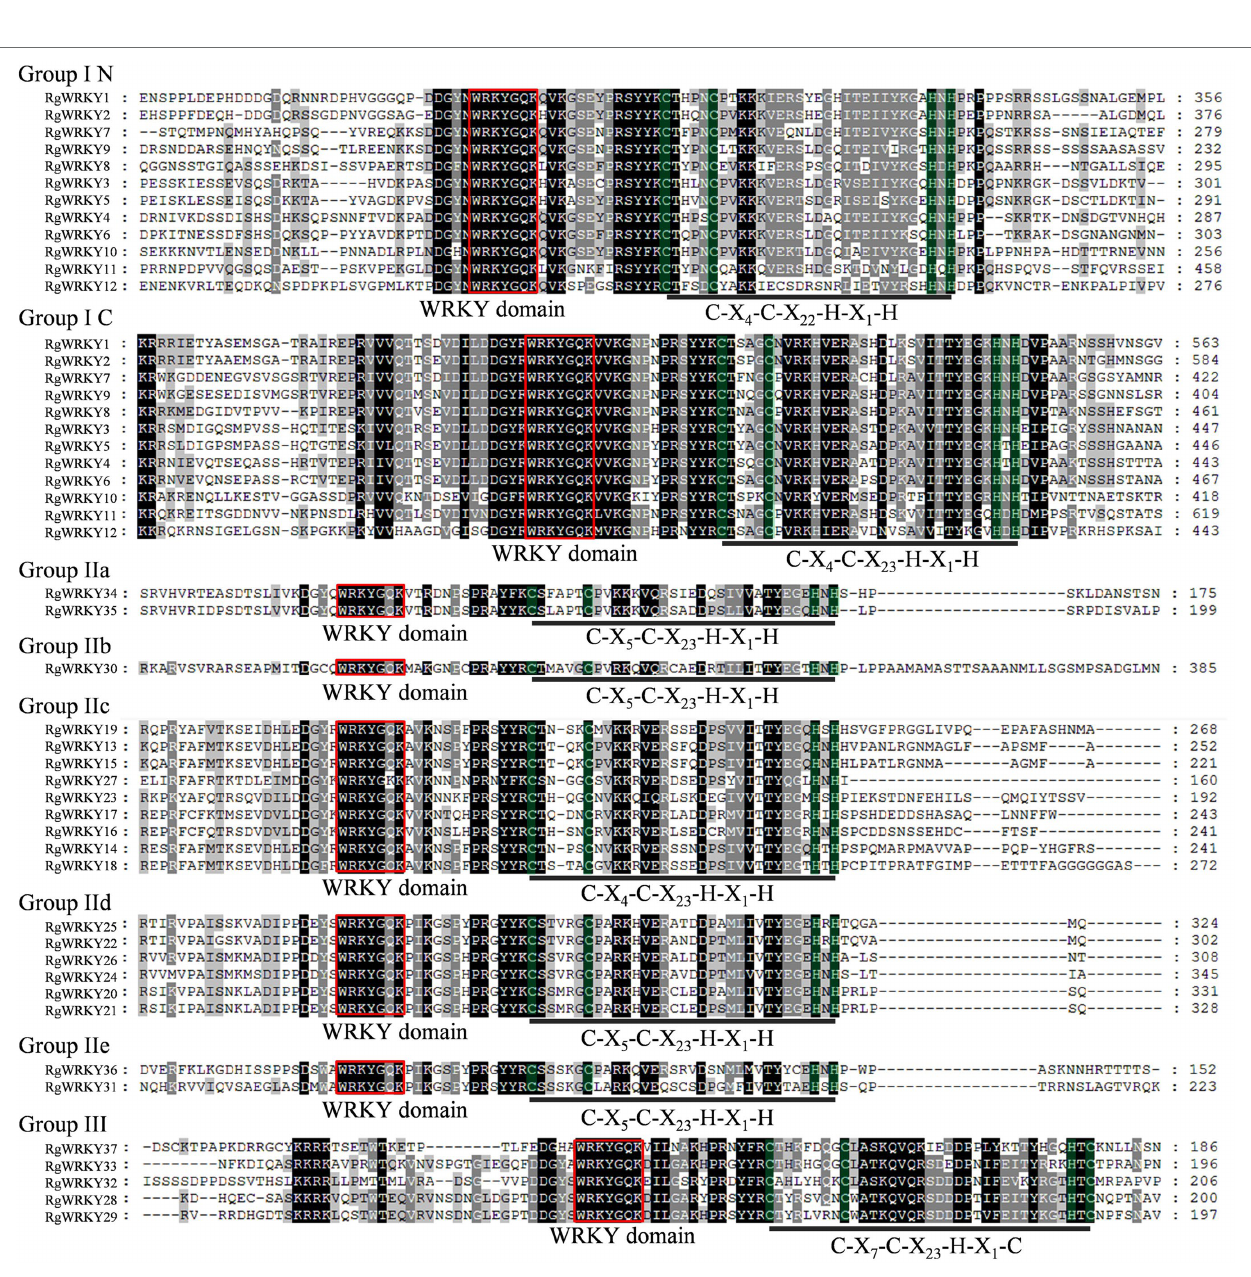
enzyme genes, and metabolites, gene expression levels of three transgenic hairy root lines (line 10, 13, and 19) and three wild-type hairy root lines (line 1, 2, and 3) were detected by RNA-seq analysis. Similar to the results of qRT-PCR detections, the expression levels of RgWRKY37 and eight structural genes ( RgUGT , RgC4H , RgTyDC , Rg4CL , RgPPO , RgALDH , RgHCT , and RgCuAO ) were generally higher in transgenic hairy lines than in wild-type lines ( Figure 10A; Supplementary Table S10 ). Pearson’s correlation